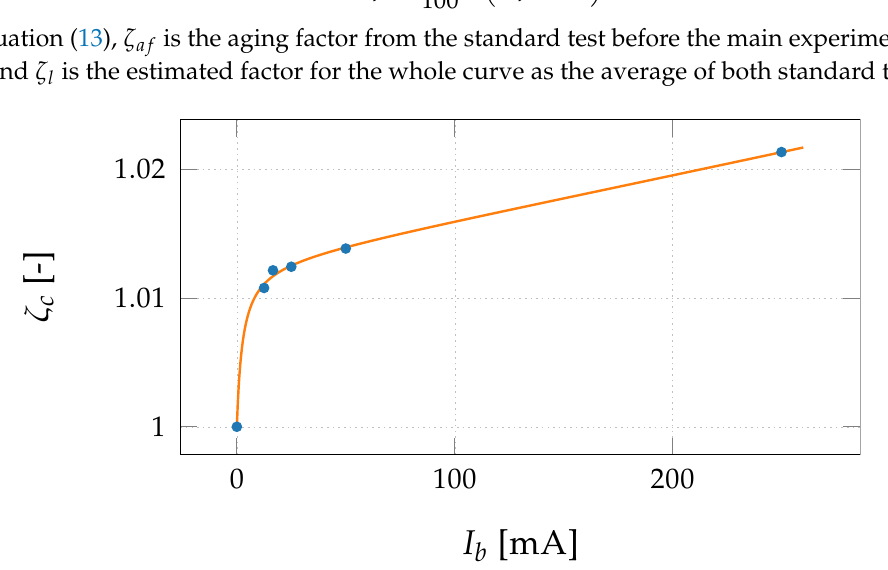
Figure 10. Found current factors from the continuous discharge curves. Solid continuous curve presents an inverse exponential function tuned to the found points, as in Equation